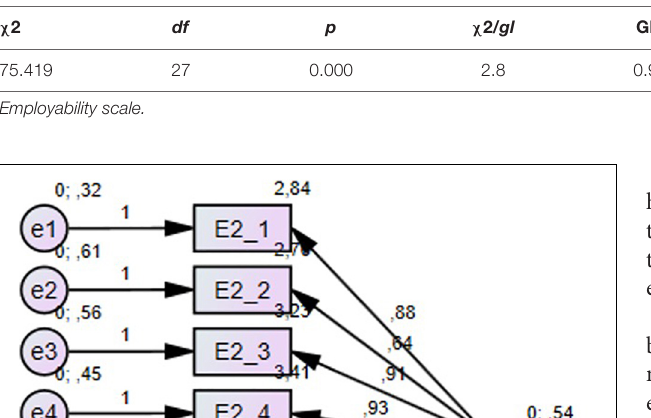
TABLE 8 | Goodness of fit indicators for the model.